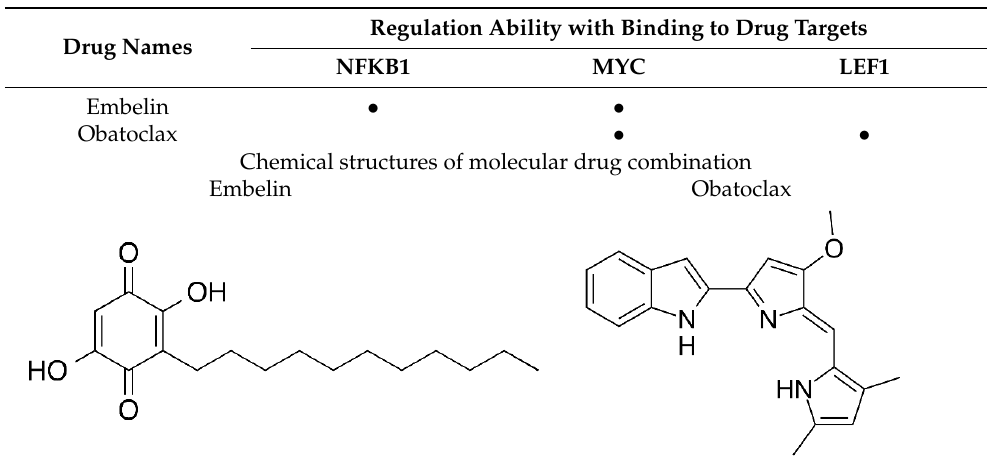
Table 2. The selected molecular drugs and their corresponding drug targets for the drug combination as the multiple-molecule drug for the treatment of MIBC.